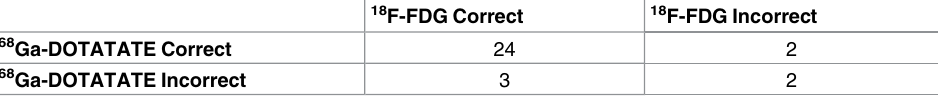
Table 2. Contingency table categorizing the diagnostic accuracyof 18 F-FDG and 68 Ga-DOTATATE PET/CT with McNemar’s chi-square test. 18 F-FDG